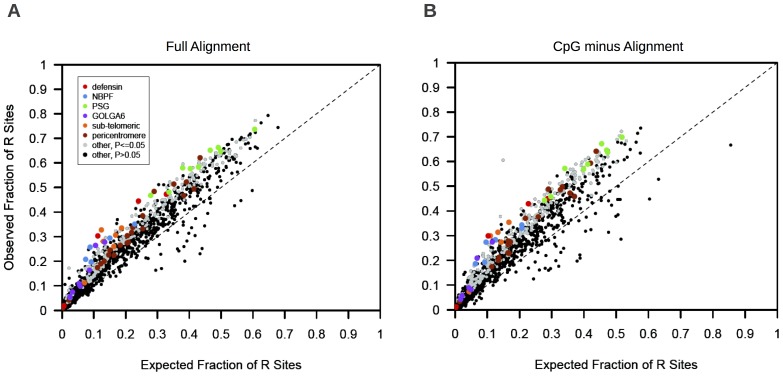
Fraction of informative sites that is reticulate.(A) The observed fraction of parsimony informative sites that is reticulate is plotted against the fraction of informative sites that is reticulate in simulated datasets generated under a model of no historical interlocus recombination. Each point corresponds to a single paralogous sequence family. Families with a significantly higher ratio of R sites to informative sites than predicted under the null model are shown in gray, or color-coded according to the figure legend. (B) The observed versus expected fraction of informative sites that is reticulate in CpG negative alignments. Black dashed line: y = x.